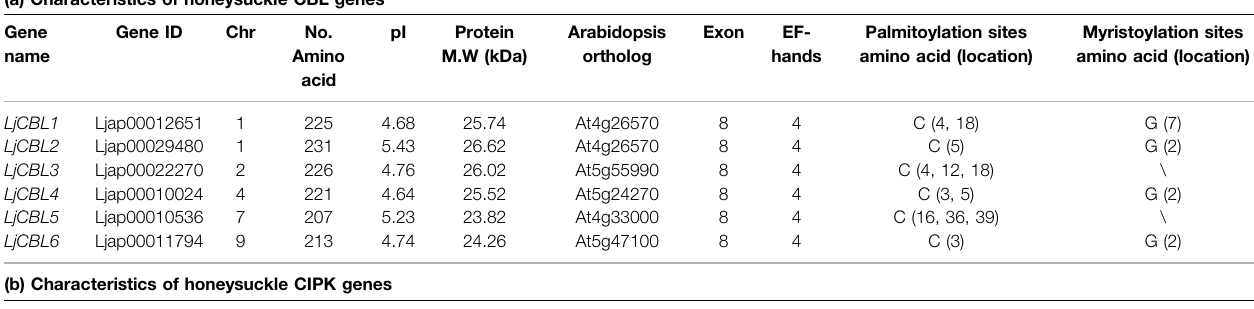
TABLE 1 | Characteristics of CBL and CIPK genes identi fi ed from